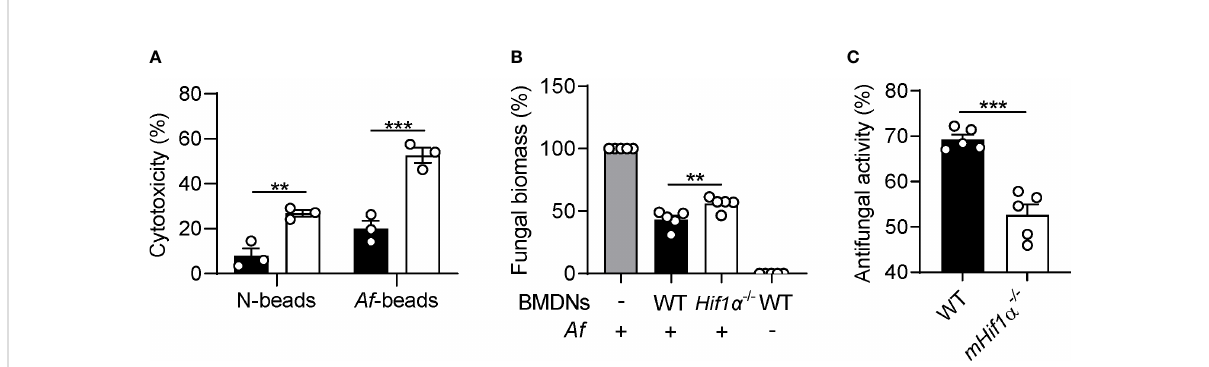
FIGURE 4 Neutrophils lacking HIF-1 a display decreased viability and antifungal activity. (A) Neutrophil viability determined by the LDH release assay after 24 hr of co-culture with Af -beads or N-beads (n = 3). (B) Hyphal growth assessment after 16 hr of co-culture of A . fumigatus hyphae with BMDNs (n = 5). (C) Neutrophil antifungal activity determined by the XTT assay after 2 hr of co-culture with pre-germinated Af -beads (n = 5). **P < 0.01; ***P <